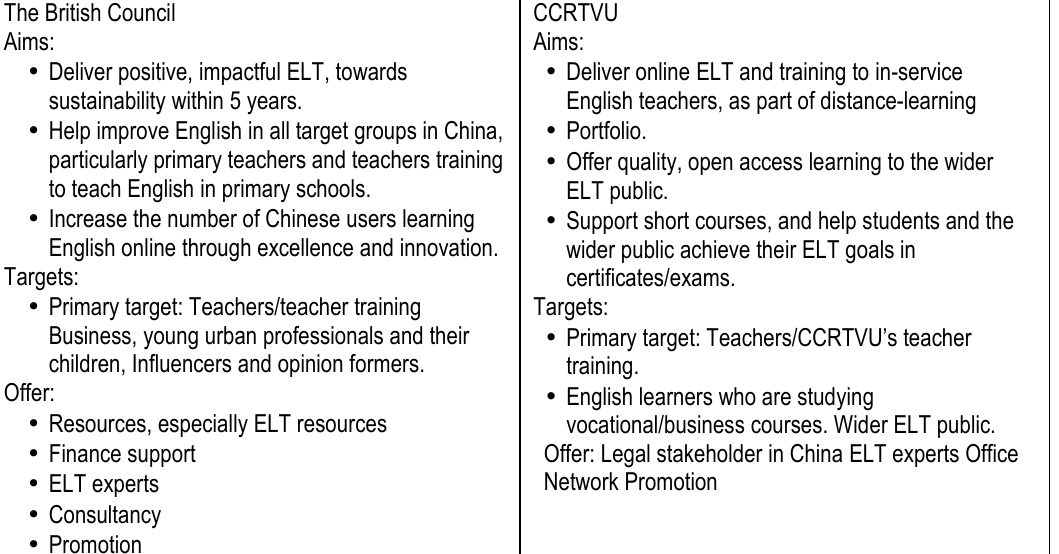
Table 1. Analysis of Overlap Areas in the Strategic Fit of All Partners The British